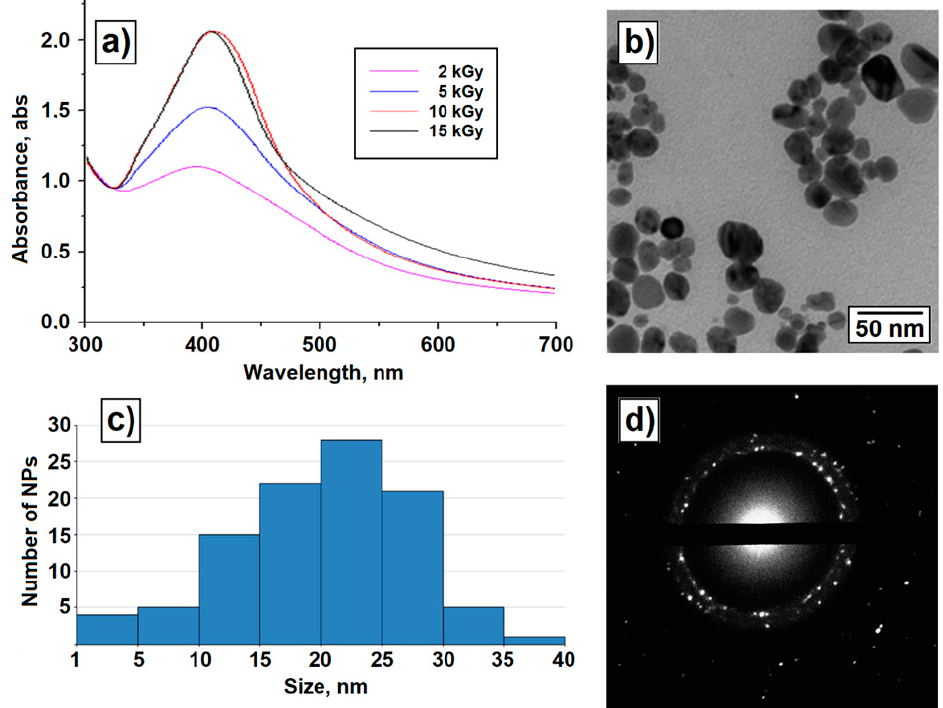
Figure 5. UV–visible spectra ( a ), micrography ( b ), histogram of the size distribution of nanoparticles ( c ), microdiffraction image ( d ) of irradiated PAA–PEI–Ag + complexes with the molar ratio of PAA/PEI units equal to 3/1.